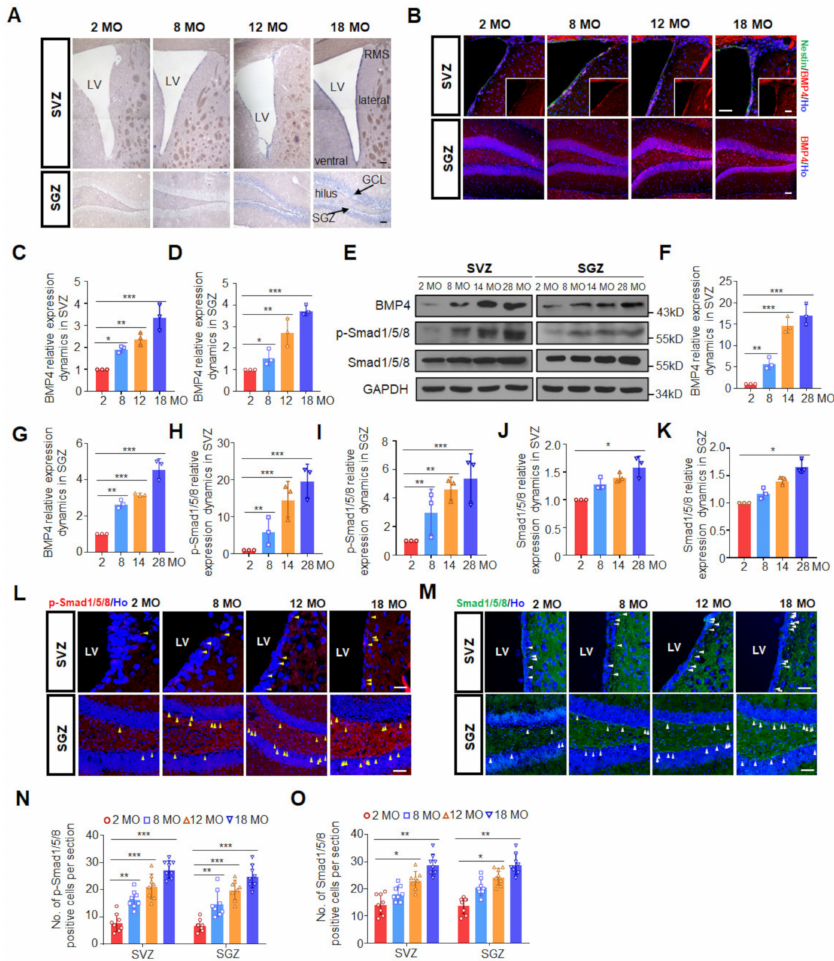
Figure 1. Canonical BMP4 signaling increases during aging. ( A ) In situ hybridization analysis of BMP4 mRNA in the SVZ (top panel, scale bar, 100 µ m) and SGZ (bottom panel, scale bar, 50 µ m) of female mice at 2, 8, 12 and 18 MO. ( B ) Representative images of BMP4 expression in the SVZ and SGZ of female mice at 2, 8, 12 and 18 MO. Scale bar, 50 µ m. ( C ) BMP4 relative expression dynamics in the SVZ of female mice at 2, 8, 12 and 18 MO. * p < 0.05, ** p < 0.01 and *** p < 0.001. ( D ) BMP4 relative expression dynamics in the SGZ of female mice at 2, 8, 12 and 18 MO. * p < 0.05, ** p < 0.01 and *** p < 0.001. ( E ) Western blotting analyses of proteins extracted from the SVZ and the SGZ of three mice at 2, 8, 14 and 28 MO. GAPDH is used as a loading control. ( F – K ) Relative quantification of Western blotting analysis of protein levels in the SVZ and SGZ of female mice at 2, 8, 14 and 28 MO: ( F ) BMP4 in the SVZ; ( G ) BMP4 in the SGZ; ( H ) p-Smad1/5/8 in the SVZ; ( I ) p-Smad1/5/8 in the SGZ; ( J ) Smad1/5/8 in the SVZ; ( K ) Smad1/5/8 in the SGZ. Data is represented as the mean protein intensity normalized to GAPDH ± S.E.M. from 3 independent mice. * p < 0.05, ** p < 0.01 and *** p < 0.001. ( L ) Representative images of p-Smad1/5/8 expression in the SVZ (top panel, scale bar, 25 µ m) and SGZ (bottom panel, scale bar, 50 µ m) of female mice at 2, 8, 12 and 18 MO. Arrowheads refer to p-Smad1/5/8 positive signals. ( M ) Representative images of Smad1/5/8 expression in the SVZ (top panel, scale bar, 25 µ m) and SGZ (bottom panel, scale bar, 50 µ m) of female mice at 2, 8, 12 and 18 MO. Arrowheads refer to Smad1/5/8 positive signals. ( N ) Quantification of p-Smad1/5/8 positive cells in the SVZ and SGZ of female mice at 2, 8, 12 and 18 MO. ** p < 0.01 and *** p < 0.001. ( O ) Quantification of Smad1/5/8 positive cells in the SVZ and SGZ of female mice at 2, 8, 12 and 18 MO. * p < 0.05 and ** p <